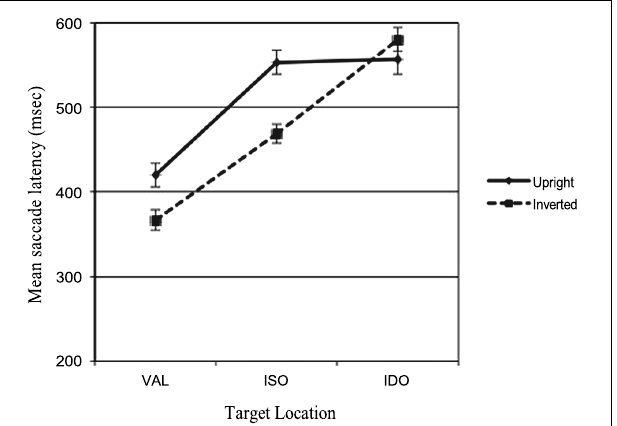
FIGURE 5 | Infants’ latencies related to the three different target locations and the two types of stimuli presented (upright and inverted